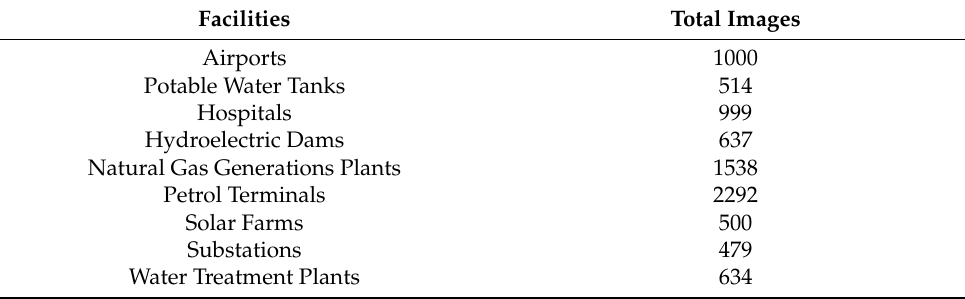
Table 2. Total images for each CI facility